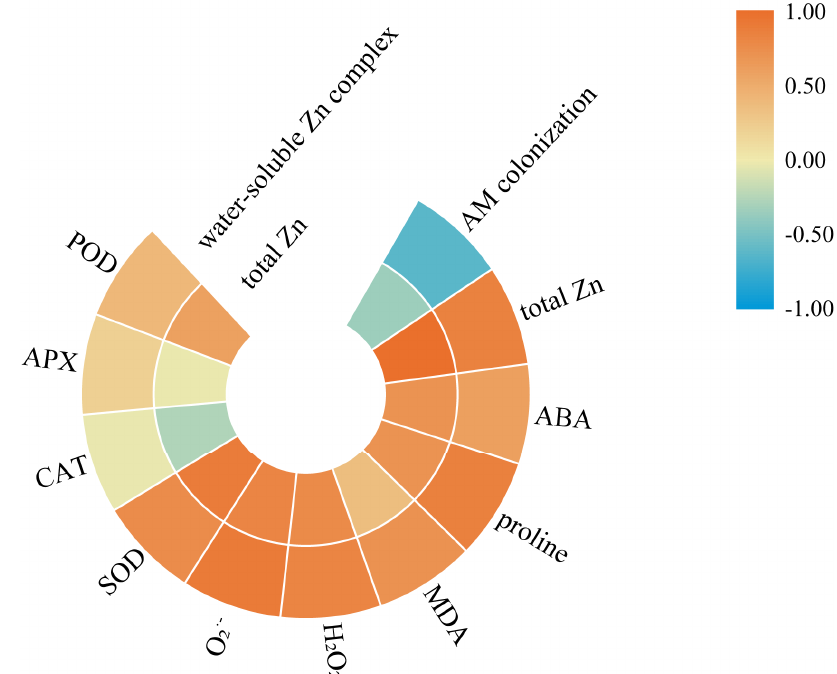
Figure 4. The relationships between water-soluble Zn complex contents, total Zn contents and AM colonization, total Zn contents, ABA contents, proline contents, MDA contents, H 2 O 2 contents, O 2 ·− generation rate, SOD activity, CAT activity, APX activity, and POD activity. Pearson’s correlation analysis was performed at the levels of 5%. n = 12.